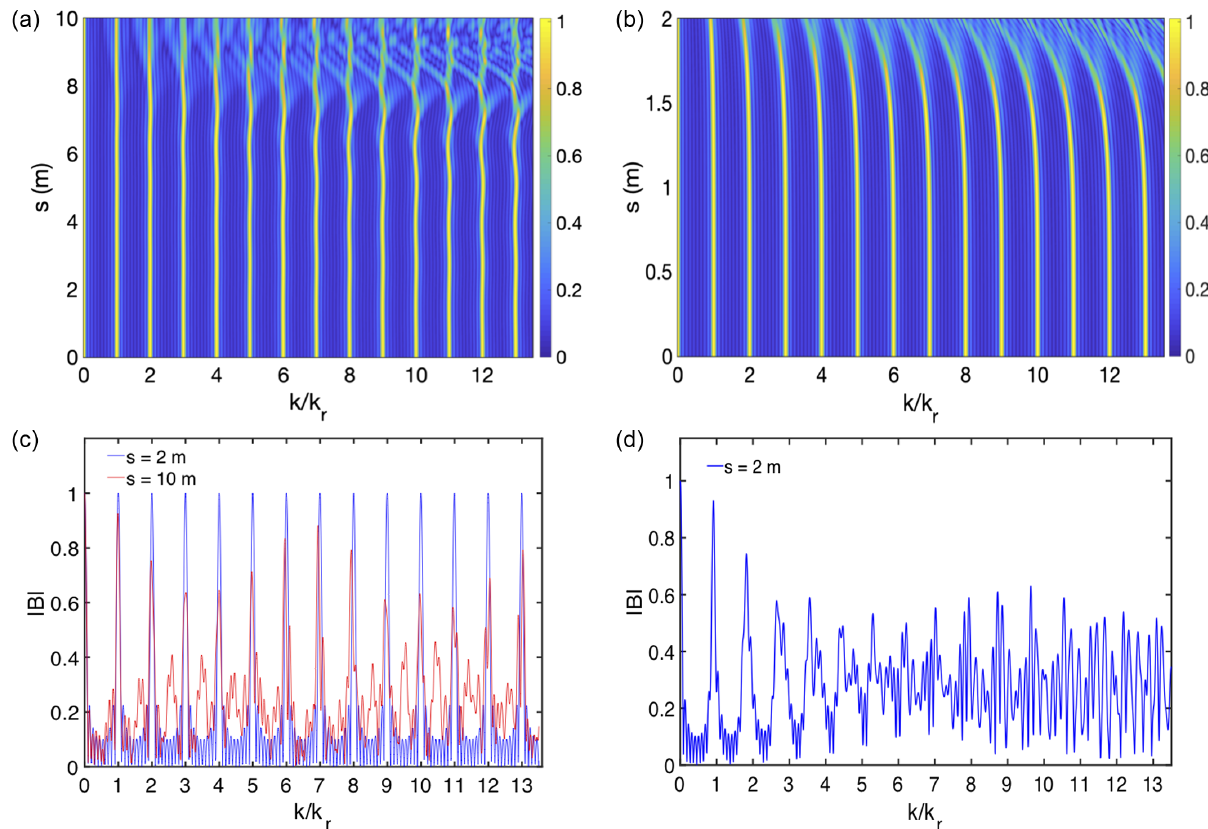
FIG. 9. Evolution of the bunching spectrum along the undulator as a function of the normalized wavenumber. (a,c) from the nonlinear model; (b,d) from the linear model without potential-well term. From (c), the sideband appears due to large-amplitude synchrotron oscillation. See the context for more discussions.